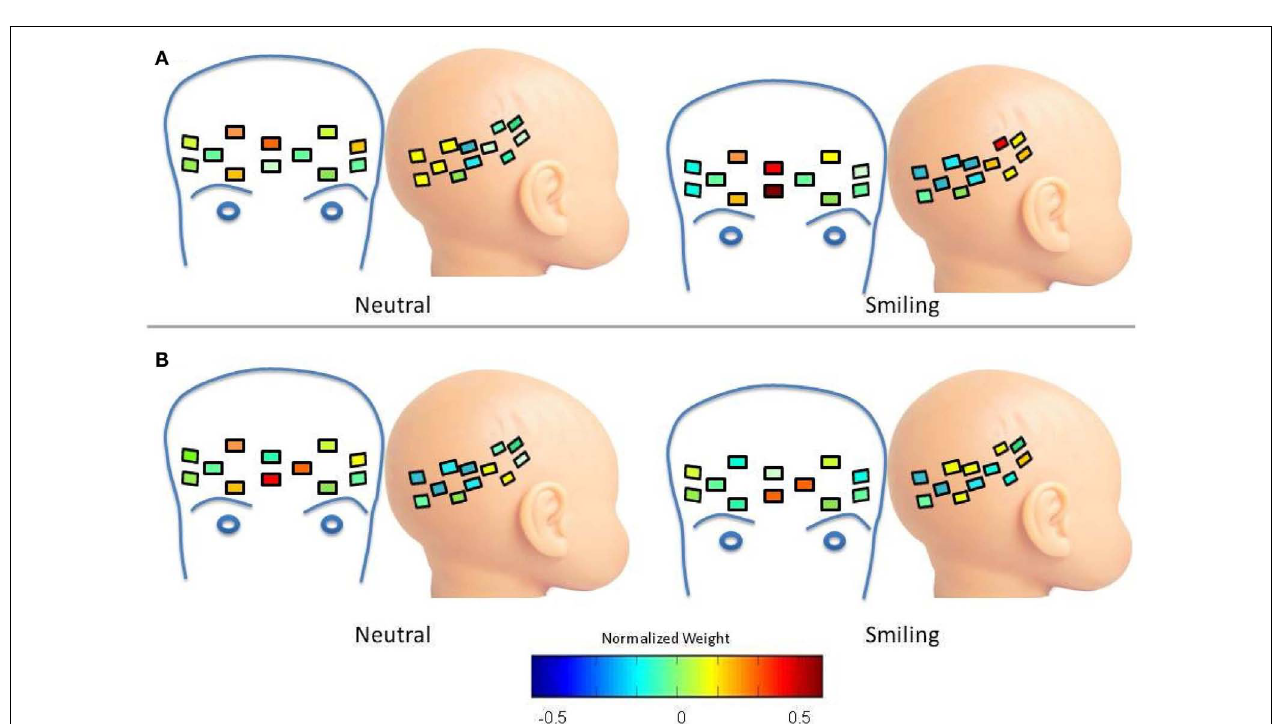
and a focally increased frontal weight. (B) HRA group.There is increased right lateral distribution of Cluster 2, but without a focal increase of weight.The spatial distribution of frontal weights is reduced between the neutral and smiling